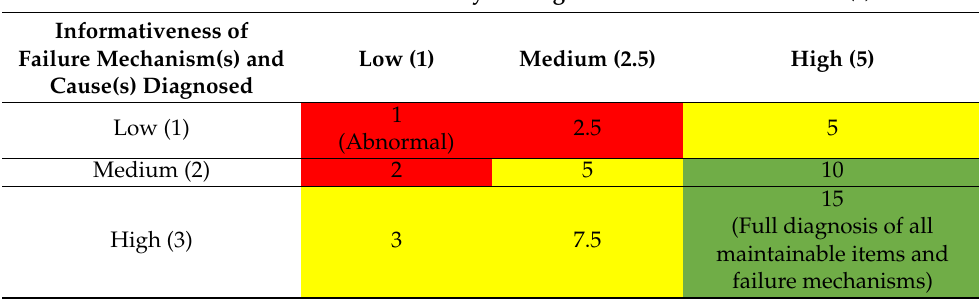
Table 4. Diagnosis priority